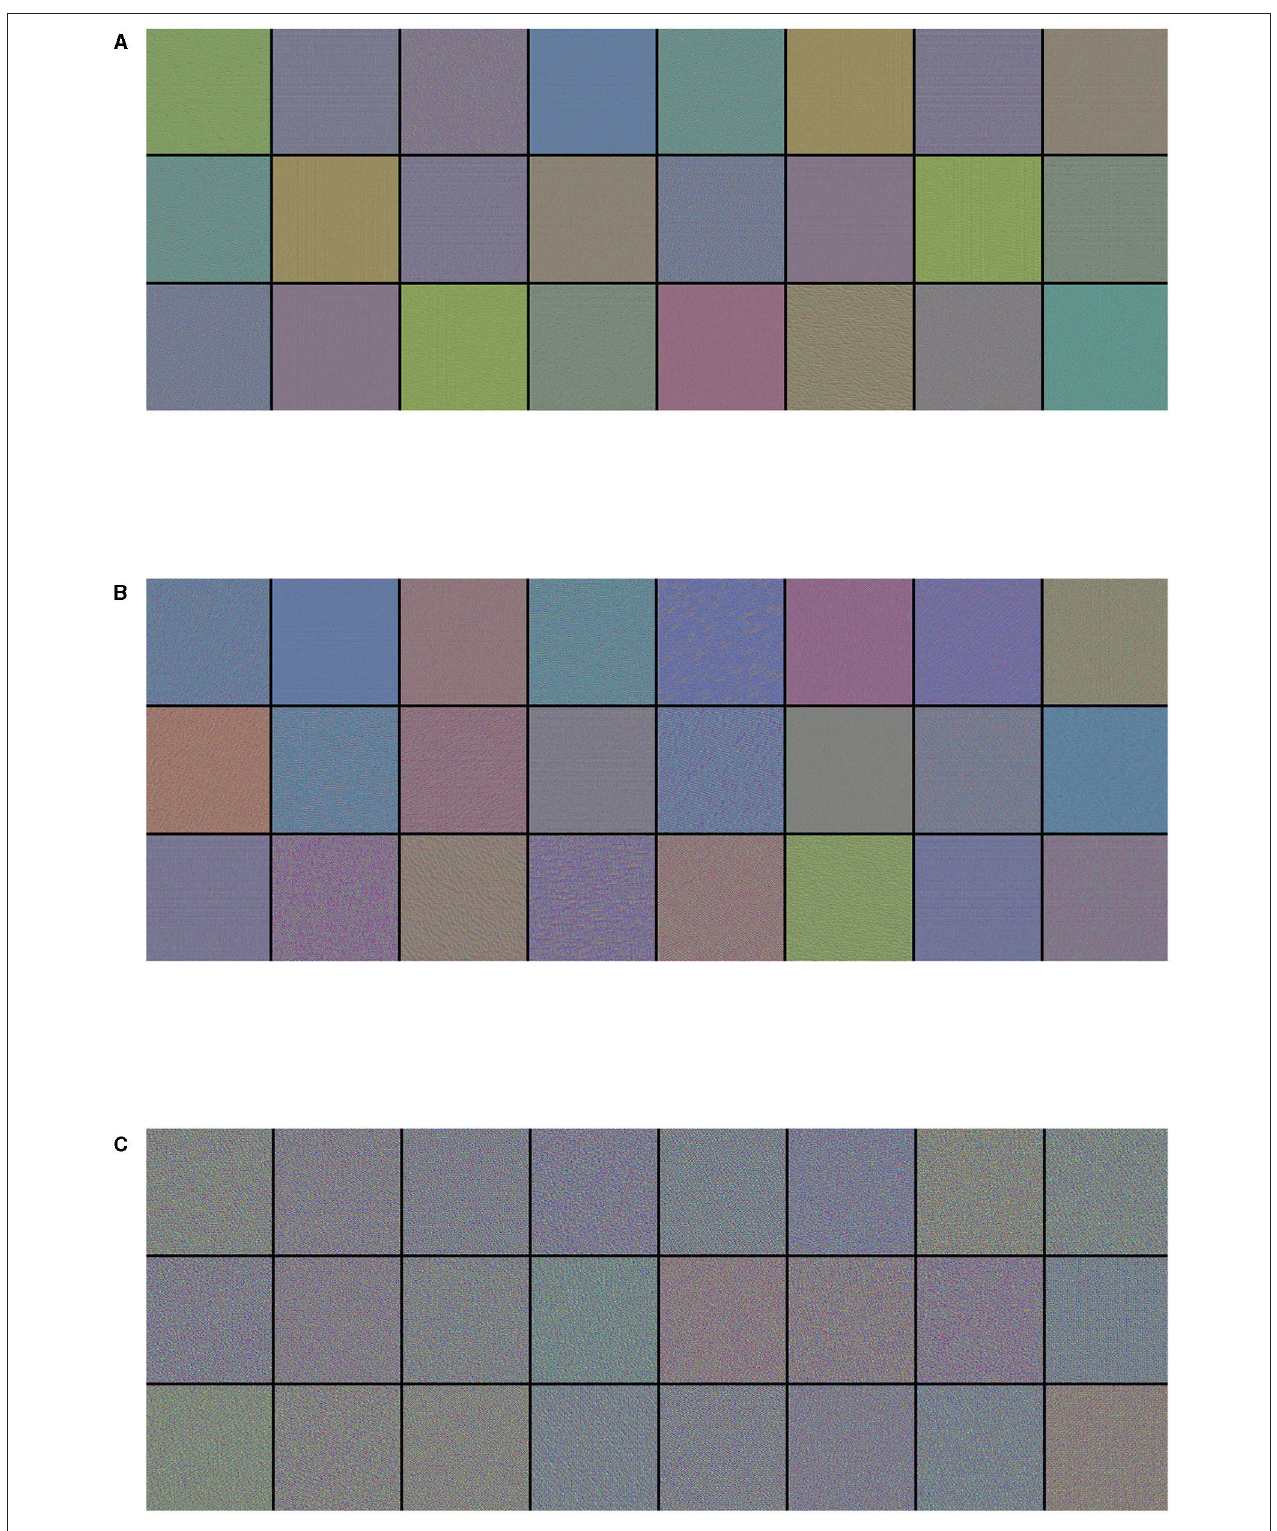
FIGURE 3 | Visualization of (A) the first 24 filters from the first convolutional layer, (B) the first 24 filters from the third convolutional layer, and (C) the first 24 filters from the fifth convolutional layer of the best performance model (Inception-v3) on the three-class classification problem. Filters act as collections of edge detectors, detect background, contours, and texture-like